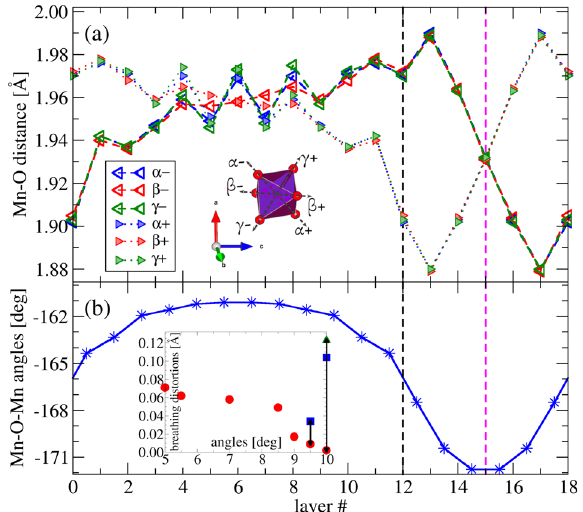
Fig. 3 Correlation between angles and distances/distortions. a Mn-O distance for the 3 inequivalent nearest neighbours, as illustrated in the inset; + and − denote increasing and decreasing c , respectively. b Opposite of the Mn-O-Mn angles ( d MnOMn ) averaged over the three directions; inset: correlation between the angles ð π (cid:2) d MnOMn Þ = 2 and the breathing distortions. In the main panels, the vertical dashed black line denotes the layer at the interface, while the dashed magenta line denotes the center of the SrMnO 3 region. Note that layers #0 and #18 are also at the interface. In the inset of panel ( b ), the vertical lines denote the range of breathing distortions for one corresponding value of the layers in the central LaMnO 3 region) mirrors the uniform shift of the band-edge, compare Figs. 3(b) and 1(b), whereas the Mn-O distances appear with oscillations in the inner LaMnO 3 region, see Fig. 3(a). Where the Mn-O-Mn bond are closer to a fl at angle (the SrMnO 3 region) the structure presents larger splitting in the Mn-O distances between increasing ^ z and decreasing ^ z , and where the Mn-O-Mn bonds are more bent (the LaMnO 3 region) the structure presents oscillating Mn-O distances and breathing modes, see Figs. 2, 3. In fact, the connection between breathing distortions and angles is even more apparent in the inset of Fig. 3(b), where fl at angles correspond to single values for the MnO 6 volumes (breathing distortion) and bent angles – in the LaMnO 3 region – correspond to large variance of the MnO 6 volumes distribution, in line with the above mentioned literature 67 . The large Mn-O distance splitting, occurring in the SrMnO 3 region, reveals a typical tendency for SrMnO 3 to ferroelasticity 74 , avoided by the symmetry with respect to the interface.